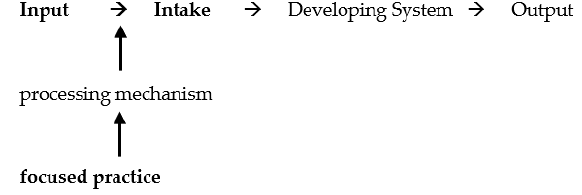
Figure 3. Traditional explicit grammar instruction in foreign language teaching (VanPatten and Cadierno 1993b, p. 46).